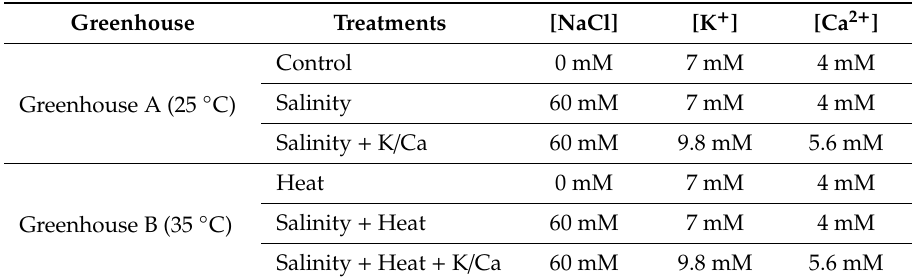
Table 2. Nutritional and environmental temperature treatments applied to tomato plants under greenhouse conditions for the physiological, biochemical and molecular